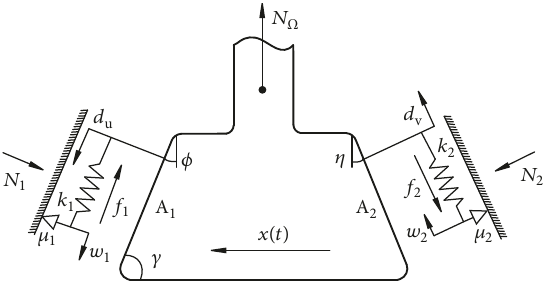
Figure 2: The mechanical model of the dry